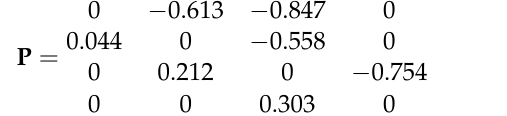
Figure 5. Changes in the values of the digraph vertices. 1—initial pastures, 2—community of wormwoods; 3—community of annual weed species, 4—open sands.